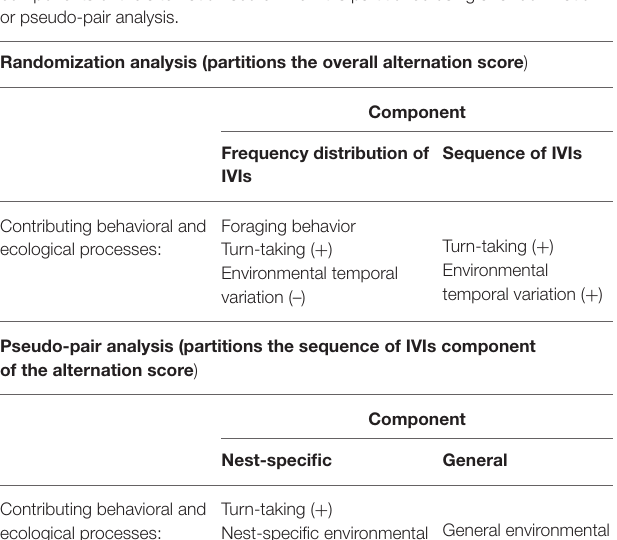
TABLE 2 | Mean and standard error of the alternation score and its IVI sequence component in real pairs, randomized real pairs, pseudo-pairs, and randomized pseudo-pairs of great